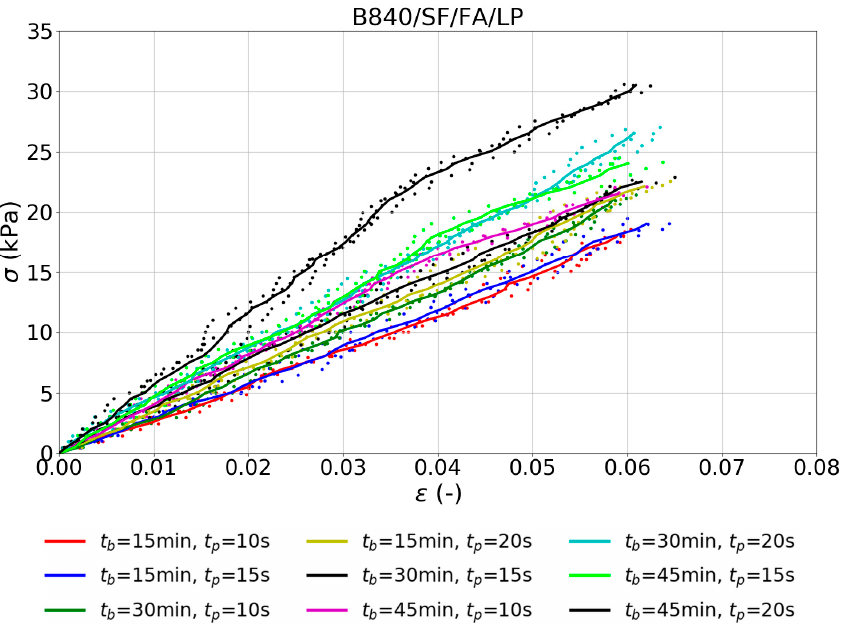
Figure 7. Stress–strain relations for mixes B840/SF/FA/LP.